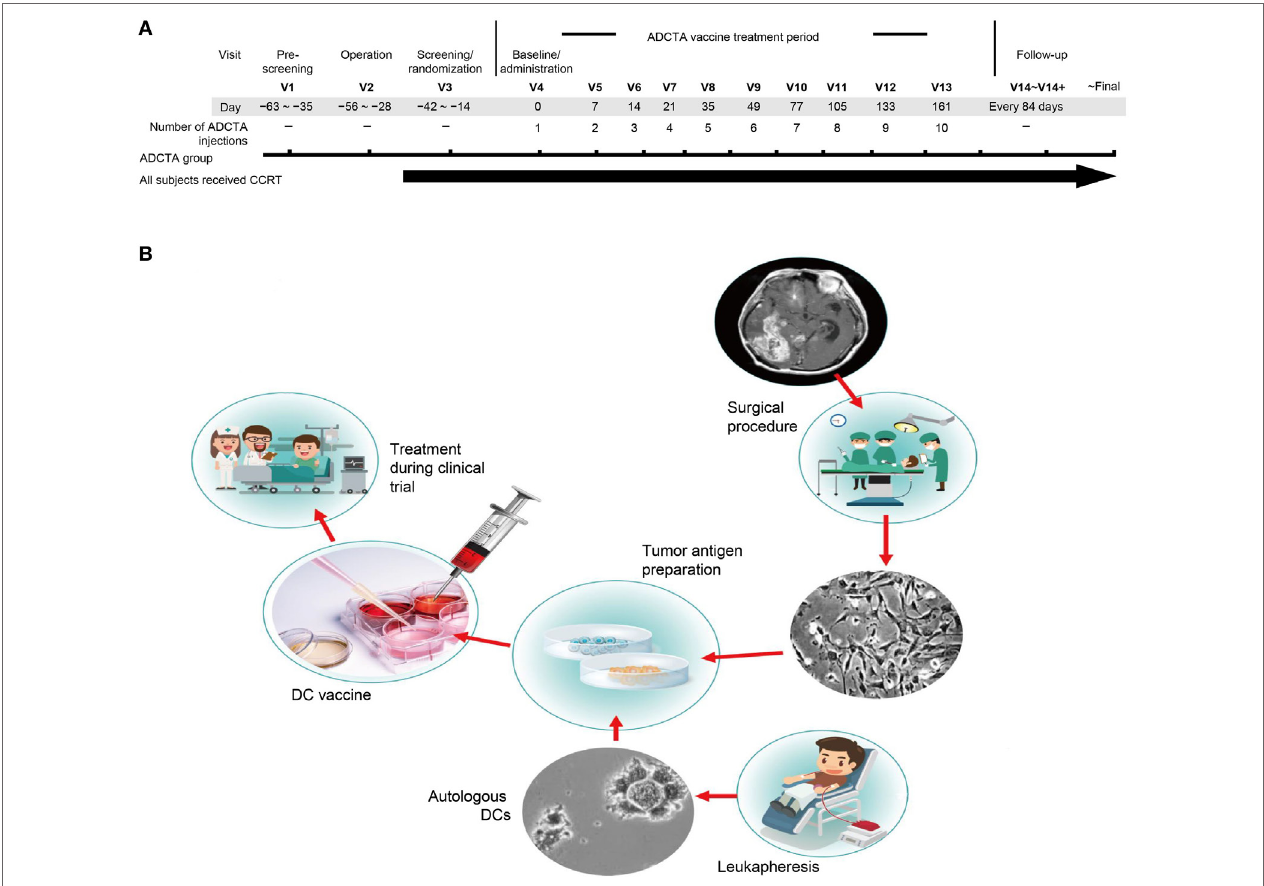
FigUre 1 | Treatment schema and vaccine preparation. Clinical schematic diagram (a) . Subjects with primary GBM will be consent for operation and concomitant chemoradiotherapy (CCRT). Subjects assigned to the ADCTA group will be designated to receive dendritic cell (DC) vaccination ten times following the clinical trial schedule after operation. V: visits to hospital, numbers following indicates times of visit. DC vaccine manufacturing protocol (B) . In China Medical University Hospital, the DC vaccine is produced in laboratories that meet the requirements of Good Tissue Practices and Good Manufacturing Practices. The final product is used in a clinical trial of autologous DC therapy for GBM patients between years 2005 and